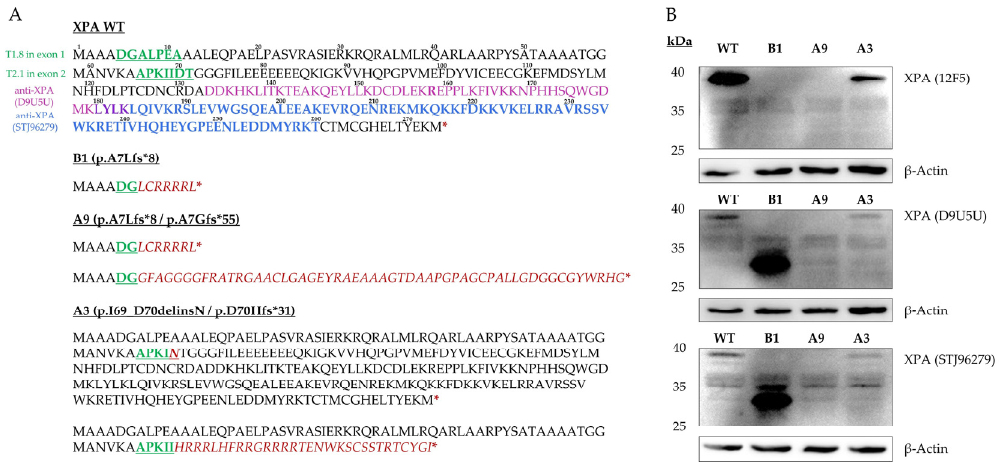
Figure 4. Protein analysis of the three XPA mutated subclonal cell lines compared to XPA WT. ( A ) Predicted AA sequences of homozygous (WT, B1) and heterozygous (A9, A3) cell lines following the regular transcription and translation start sites are depicted. The XPA WT is based on NCBI transcript CCDS6729. AA sequences corresponding to the sgRNA-targeted regions are shown in green, altered AA sequences in red. Stars indicate translation termination sites upon the first in-frame stop codon. The approximate epitopes of the anti-XPA antibodies are highlighted for D9U5U (purple, targeting ≈ 50 AA surrounding the published target AA R158) and STJ96279 (blue) clones. The epitope of the 12F5 antibody is not published. ( B ) Immunoblotting with the 12F5 antibody showed complete loss of full length XPA in exon 1 knockout cell lines, B1 (p.A7Lfs*8) and A9 (p.A7Lfs*8/p.A7Gfs*55), while still producing a weaker XPA signal in A3 (p.I69_D70delinsN/p.D70Hfs*31) cells. Using D9U5U and STJ96279, a smaller band was newly detected in B1, presumably representing a de novo XPA variant. The AA one-letter-code was used in both panels. AA, amino acid(s); sgRNA, single-guide RNA; WT,